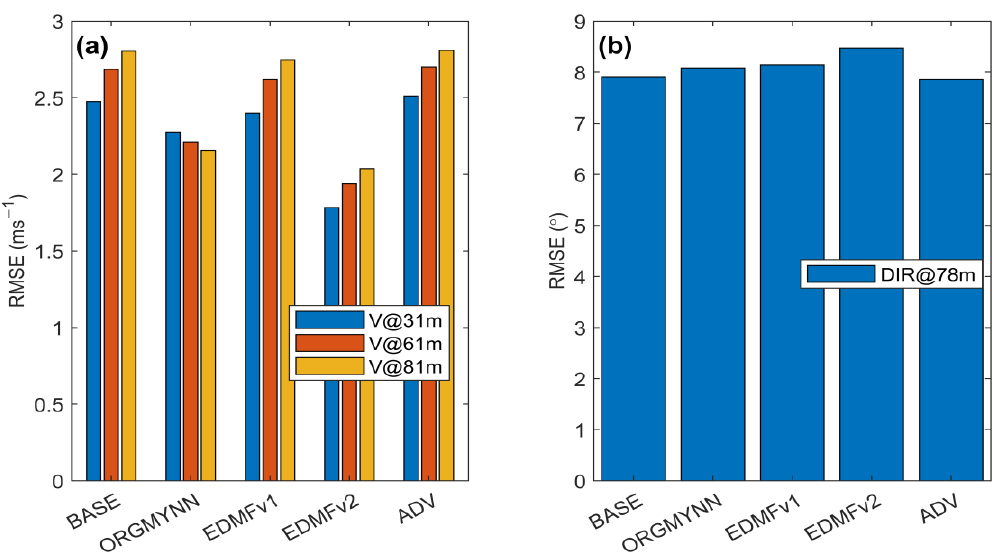
Figure 3. RMSE results of comparisons of simulated and observed data for ( a ) wind speed and ( b ) wind direction.